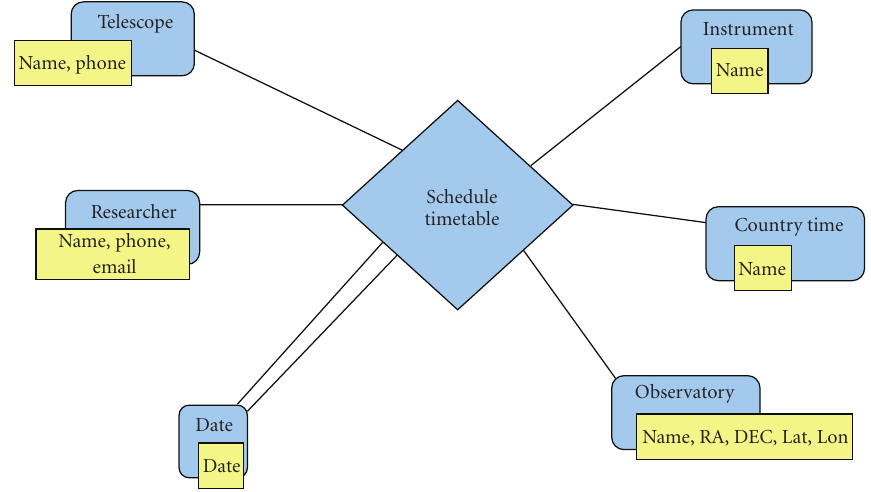
Figure 4: Entity relationship model.